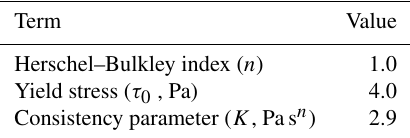
Table 1. Bingham fluid Herschel–Bulkley model parameters used in Poiseuille flow test cases, from Filali et al. (2013).